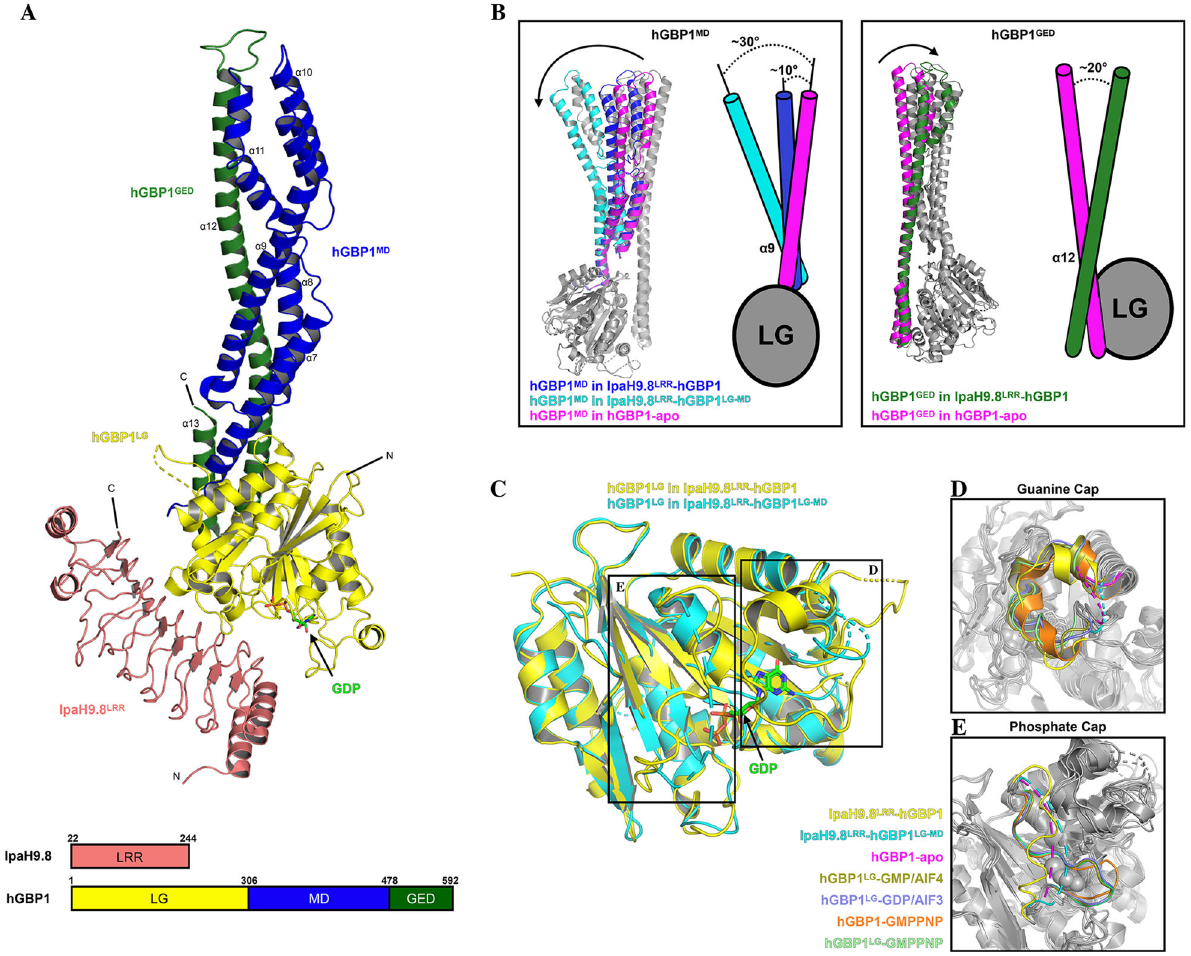
Fig. 3 Overall structure of IpaH9.8 LRR – hGBP1 complex. A Top, the cartoon model of IpaH9.8 LRR and hGBP1 complex, with IpaH9.8 LRR colored salmon, hGBP1 LG yellow, hGBP1 MD blue, and hGBP1 GED forest. The GDP molecular structure is represented as sticks (C: green, O: red, P: orange, N: blue). The α -helixes ( α 7 – α 13) in hGBP1 MD and hGBP1 GED are labeled as such. Bottom, schematic representation of the IpaH9.8 LRR and hGBP1 constructs for crystallization. B Left frame — left, superimposition of the structures of hGBP1 by the LG domain, with the MDs differentiated by colors. Arrows indicate the rotation of the MDs when bound to IpaH9.8 LRR . Left frame — right, cartoon schematic of the difference in angles of α 9 for each hGBP1, as in left frame-left. Right frame — left, superimposition of the structures of hGBP1 by the LG domain with the GED domains differentiated by colors. Arrows indicate the rotation of GED when bound to IpaH9.8 LRR . Right frame — right, cartoon schematic of differences in angle of α 12 for each hGBP1, as in right frame-left. C Superimposition of hGBP1 LG with IpaH9.8 LRR – hGBP1 (yellow) and IpaH9.8 LRR – hGBP1 LG-MD (cyan), with a GDP molecule in IpaH9.8 LRR – hGBP1 represented as sticks. D The guanine caps in different hGBP1 LG domains are differentiated by colors. E The phosphate caps in different hGBP1 LG domains are differentiated by colors. Structure sources: IpaH9.8 LRR – hGBP1 (this study), IpaH9.8 LRR – hGBP1 LG-MD (PDBID: 6K2D), hGBP1-apo (PDBID: 1DG3), hGBP1 – GMPPNP (PDBID: 1F5N), hGBP1 LG – GMPPNP (PDBID: 2BC9), hGBP1 LG – GDP/AIF3 (PDBID: 2B92), and hGBP1 LG – GMP/AIF4 (PDBID: NEL domain to inhibit IpaH9.8. The LRR-CT of IpaH9.8 LRR-Sub and IpaH9.8 LRR-iso were superimposed onto the IpaH9.8 FL structure (Fig. 5C), revealing that the hydrophobic pocket of IpaH9.8 LRR-Sub was shallower than in IpaH9.8 LRR-FL (Fig. 5D, left). Surprisingly, in the IpaH9.8 LRR-Sub structure, this hydro- phobic pocket demonstrated minor overlap with the Phe395 from the NEL domain (Fig. 5D, middle). Similar observations were also made for IpaH9.8 LRR-Sub ’ (Supplementary Fig. 5B). In contrast, the pocket in IpaH9.8 LRR-iso was quite similar in IpaH9.8 LRR-FL and demonstrated no clash with the NEL domain (Fig. 5D, right), indicating that different conformations of the hydrophobic pocket were not due to differences in the NEL domain, but because of substrate-binding. Altogether, these results demonstrated that substrate-binding induced conformational changes in LRR-CT, which resulted in destabilization of the hydrophobic cluster and LRR-CT, which could disrupt the LRR – NEL interaction.